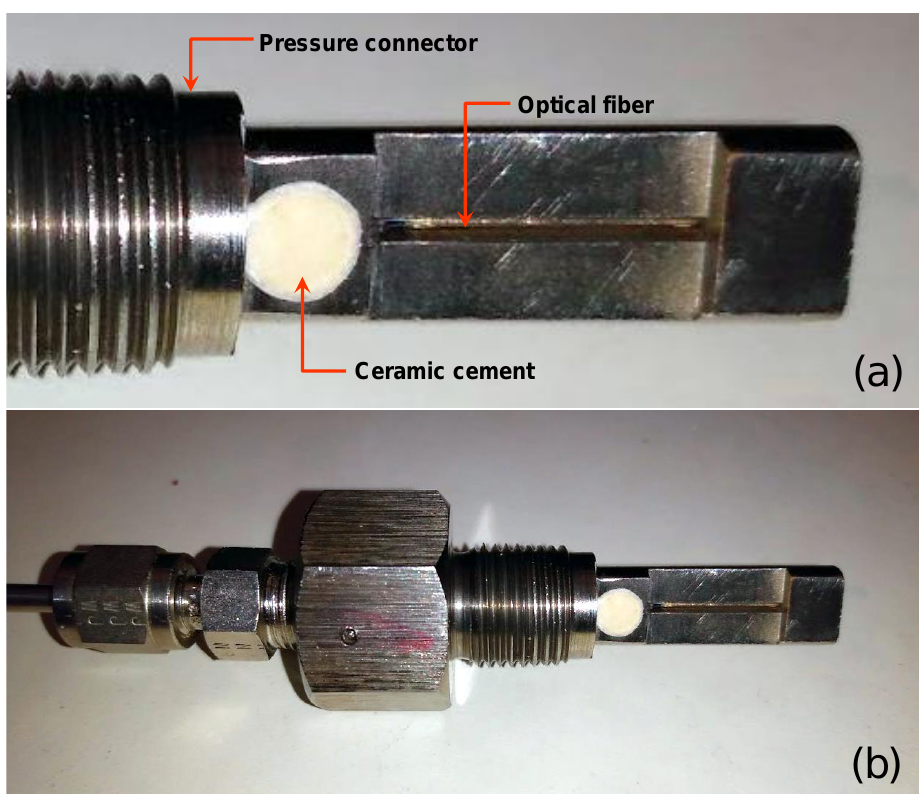
Figure 4. ( a ) Hole of a pressure connector filled with the ceramic cement and ( b ) the pressure connector using the ceramic cement as a sealing technique.